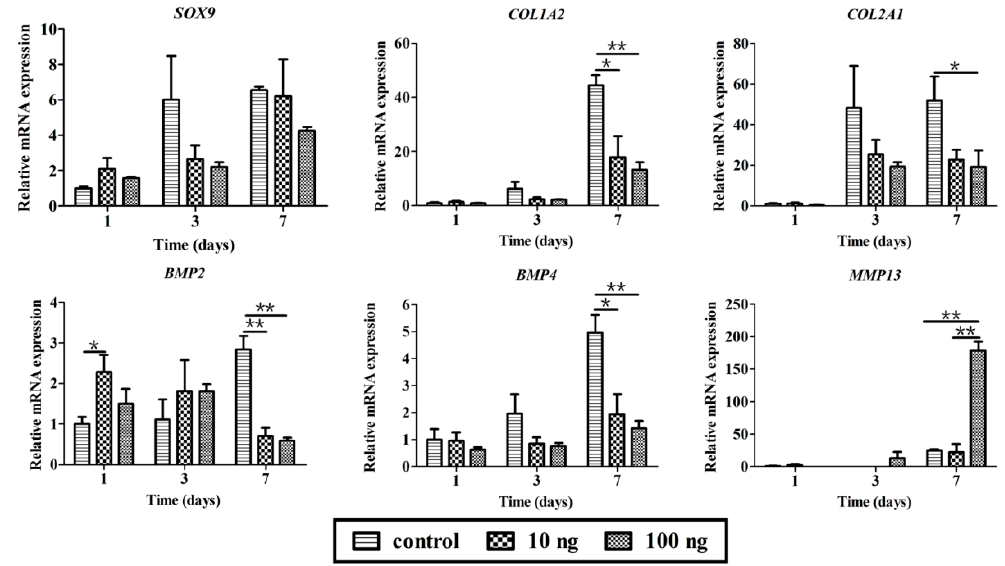
Figure 4. Effects of BMP3 on gene expression of chondrocytes in vitro . 10 ng means 10 ng/mL, 100 ng means 100 ng/mL BMP3 in the culture media; control, without BMP3. Mean ± SD, n = 3; * p < 0.05, ** p < 0.01.